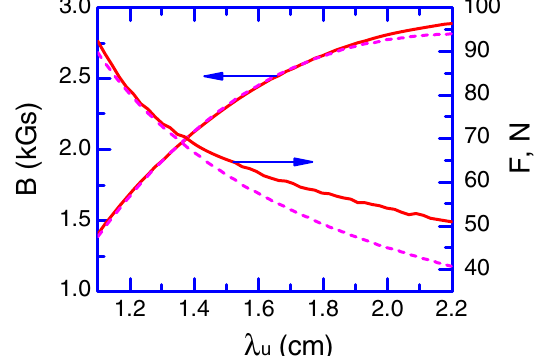
FIG. 3. Dependence of the first harmonic amplitude and re- pulsion force on the undulator period. The solid curves are for the simulation results, the dashed curves are for the analytical expressions.